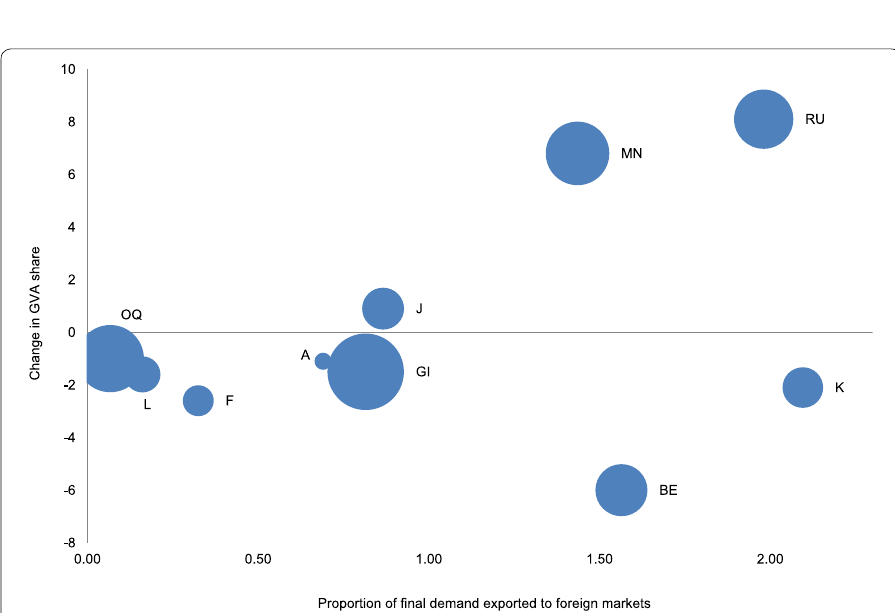
Fig. 4 Growth and foreign orientation of sectors. The bubble size represents the relative size of value added of the sector in 2017. Y- axis represents the change in the share of gross value added of each sector in total value added between 2006 and 2017. X- axis shows the degree of foreign orientation of each sector. The sectors are classified as follows: A agriculture, forestry and fishing, BE mining and quarrying; manufacturing; electricity, gas, steam and air conditioning supply; water supply; sewerage, waste management and remediation activities, F construction, GI wholesale and retail trade; repair of motor vehicles and motorcycles; transportation and storage; accommodation and food service activities, J information and communication, K financial and insurance activities, L real estate activities, MN professional, scientific and technical activities; administrative and support service activities, OQ public administration and defence; compulsory social security; education; human health and social work activities, RU arts, entertainment and recreation, repair of household goods and other